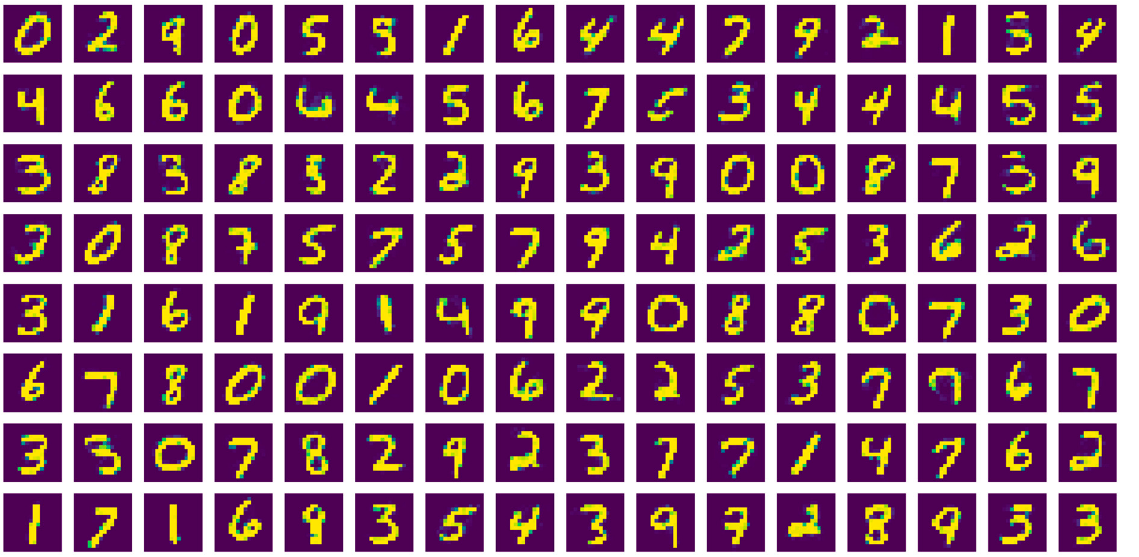
Figure 5. (a) Accuracy vs. number of input layer neurons; (b) accuracy vs. number of feature layer neurons.